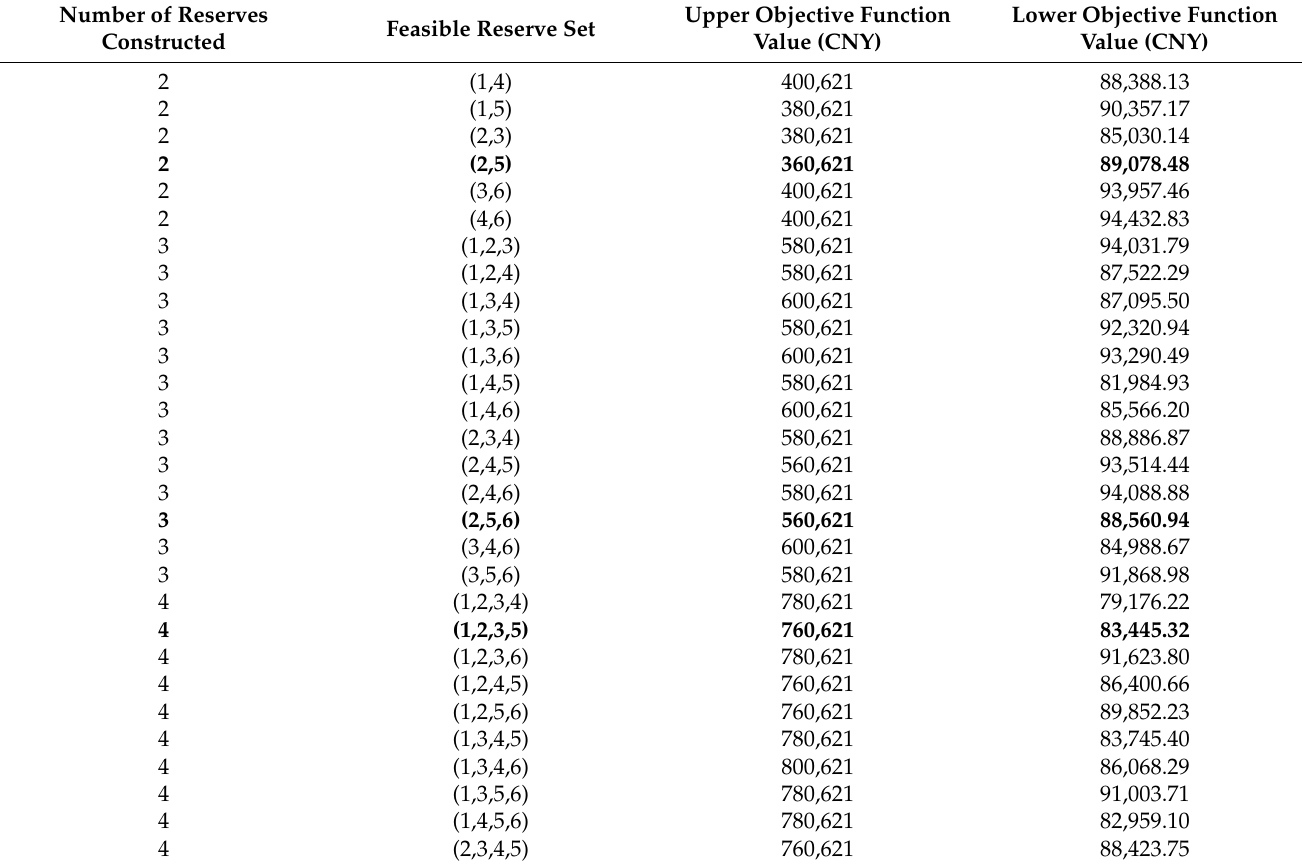
Table 5. Ant colony–tabu search algorithm to obtain feasible set and its